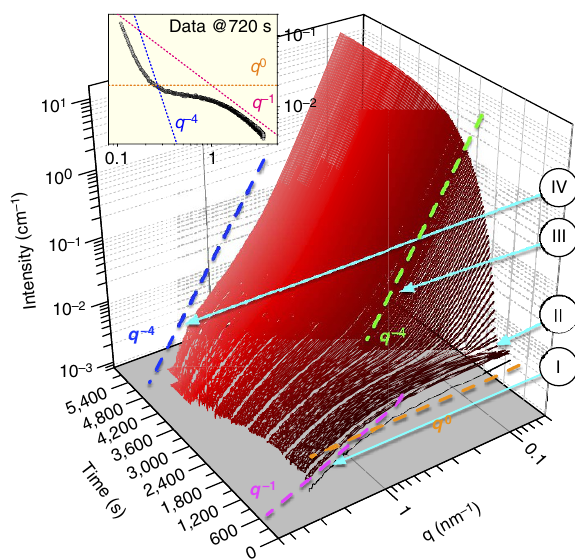
Figure 1 | Time-resolved in situ SAXS patterns. The formation of solids in the experiment with an initial concentration of 50mmoll (cid:3) 1 CaSO 4 and equilibrated at 12 (cid:2) C; (I): formation of small primary entities/scatterers as evidenced through the change in I(q) p q (cid:3) 1 for q 4 1nm (cid:3) 1 and I(q) p q 0 for q o 1nm (cid:3) 1 (pink and orange dashed lines); (II) development of a structure factor; (III) formation and development of large scattering features evidenced through the increase in intensity at q o 1nm (cid:3) 1 ; this change followed a dependence of I(q) p q (cid:3) 3 4 a 4 (cid:3) 4 (where a is the exponent— green dashed line); (IV) growth of the primary species manifesting itself at q 4 1nm (cid:3) 1 by the shift of the scattering curves towards lower q values and the gradual decrease in intensity towards I(q) p q (cid:3) 4 (blue dashed line); the inset shows a selected scattering curve and indicates the significance of the I ( q ) dependence of the scattering exponents q (pink, orange and blue dashed lines) pointing out the characteristic features in scattering as described in the main